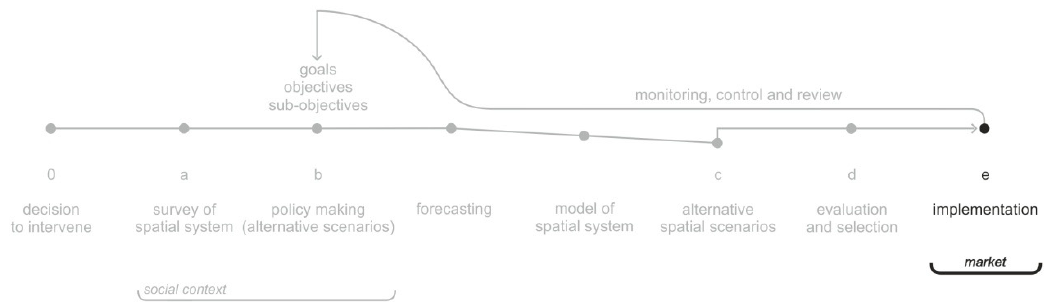
Figure 7. The exclusive emphasis on implementation, according to neo-liberal land-use planning models, with the comprehensive model’s components in the background. Gray circle: lack of the corresponding McLoughlin component. Dark circle: the central component. Below the axis: contextual factors.